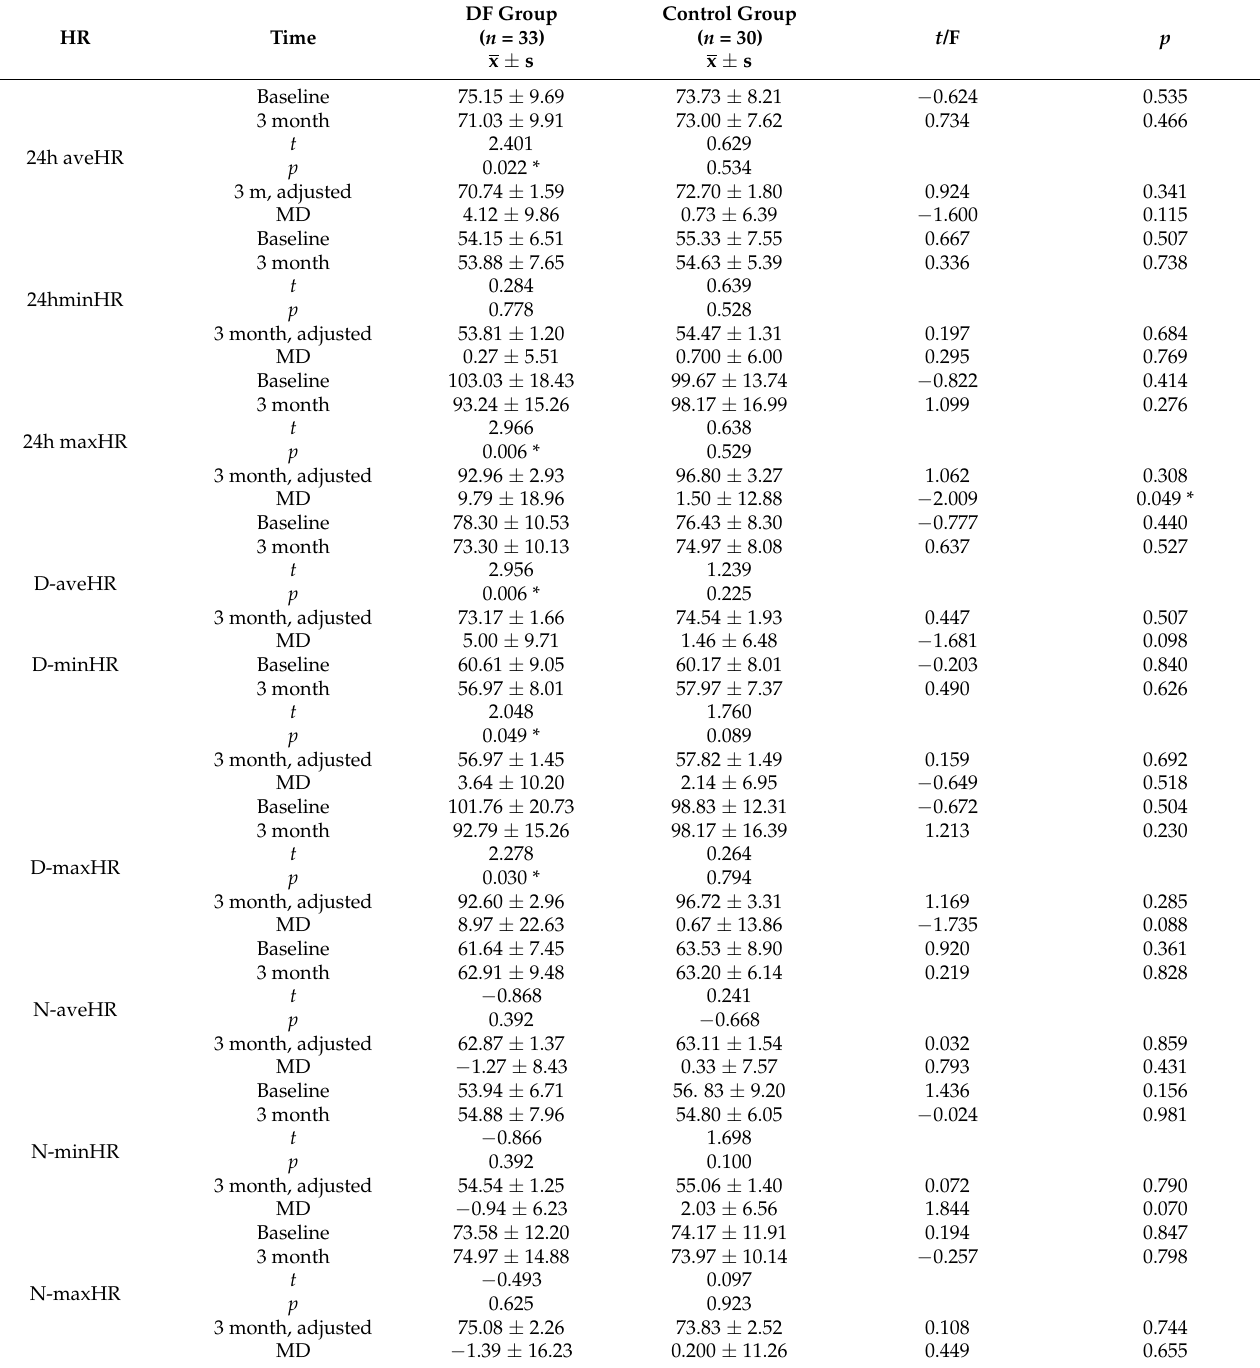
Table 4. Comparison of HR between/within two